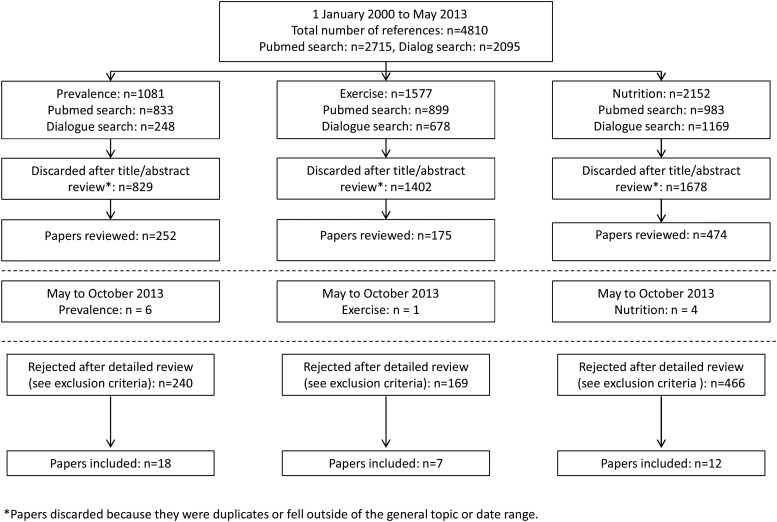
Selection of papers.